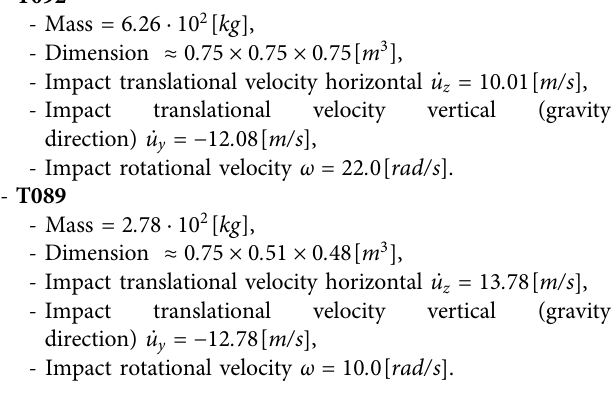
Frontiers in Built Environment |